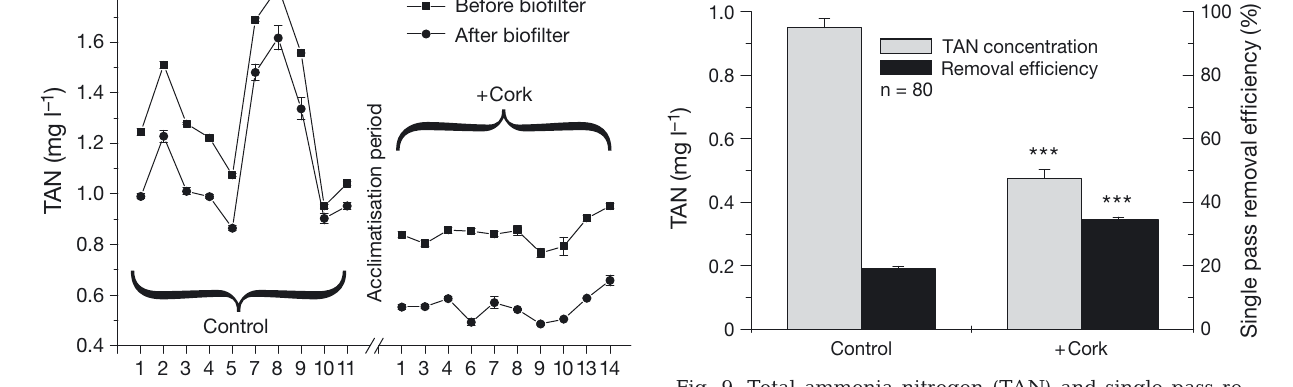
Fig. 9. Total ammonia nitrogen (TAN) and single pass re- moval efficiencies during the control diet and cork diet phases of the experiment. Bars marked with asterisks are Fig. 8. Timeline of total ammonia nitrogen (TAN) during the significantly different from the control (p < 0.0001). trial, measured for both diets before and after the biofilter (n = 160). Values are means ± SE